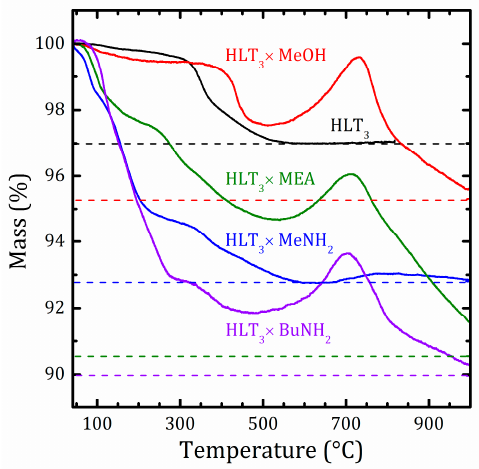
Figure 3. Thermal gravimetric (TG) curves for the initial HLT 3 and organic-inorganic HLT 3 × MeOH, HLT 3 × MeNH 2 , HLT 3 × MEA, and HLT 3 × BuNH 2 compounds. Masses after the final isothermal step are shown by dashed lines.